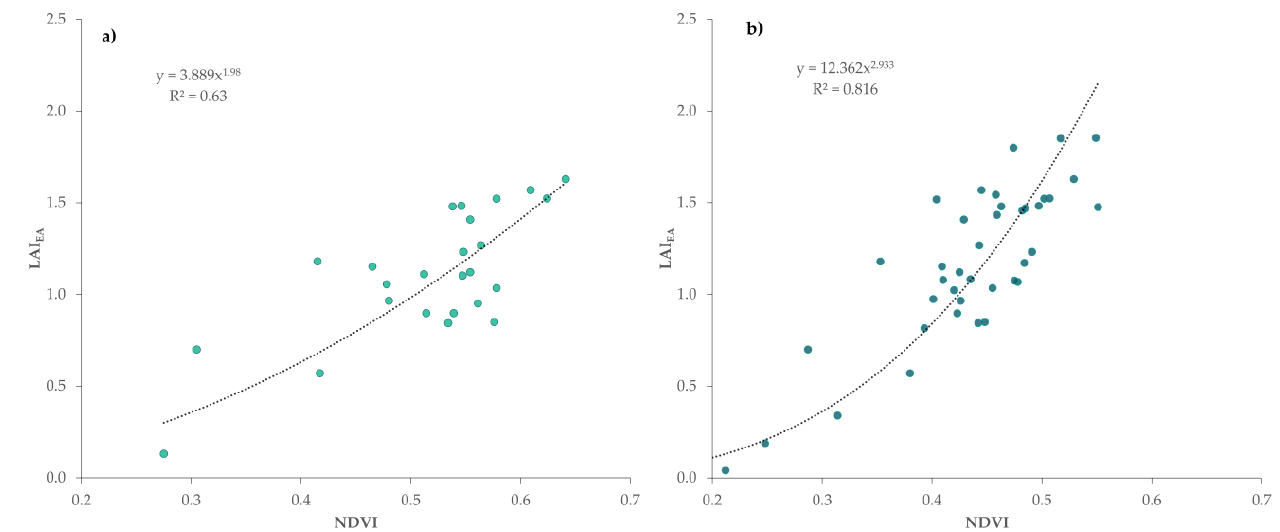
Figure 6. Regression analysis between the adjusted leaf area index ( LAI EA ) and the normalized difference vegetation index ( NDVI ) estimated from Landsat 7–8 ( a ) and Sentinel-2 ( b ) data. The dotted line is the regression line that describes the response of LAI EA to NDVI